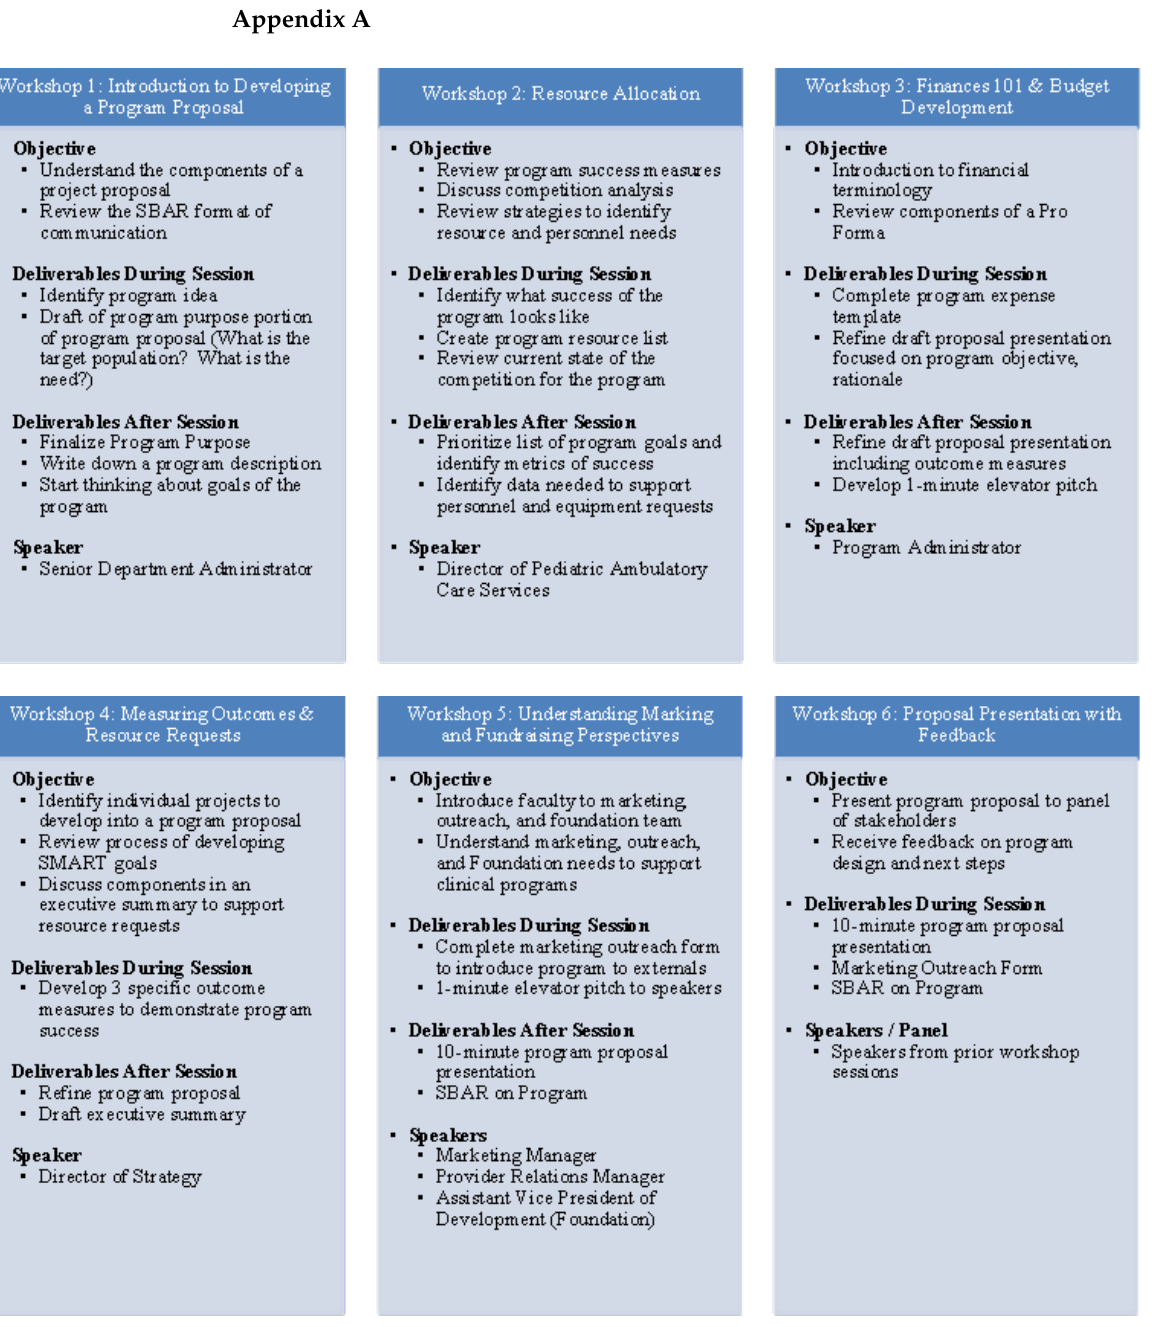
Figure A1. Program Development Practicum workshop sessions and deliverables.